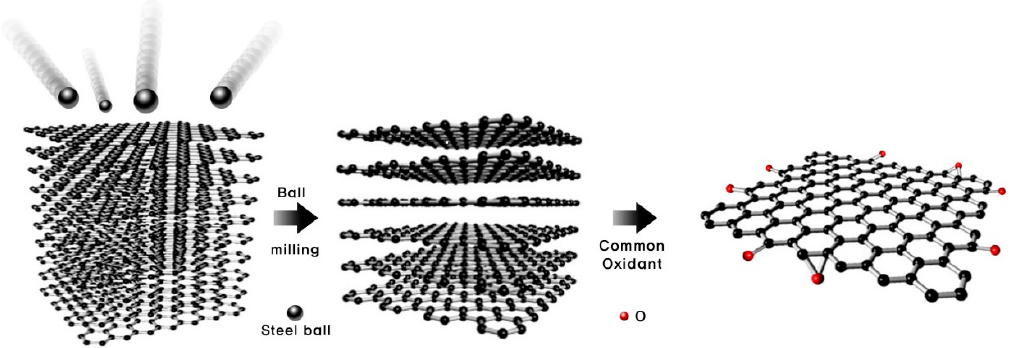
Figure 2. Mechanochemical process of producing ball-milling graphene oxide nanoflake (reproduced with permission from [15]. Copyright Elsevier, 2016).